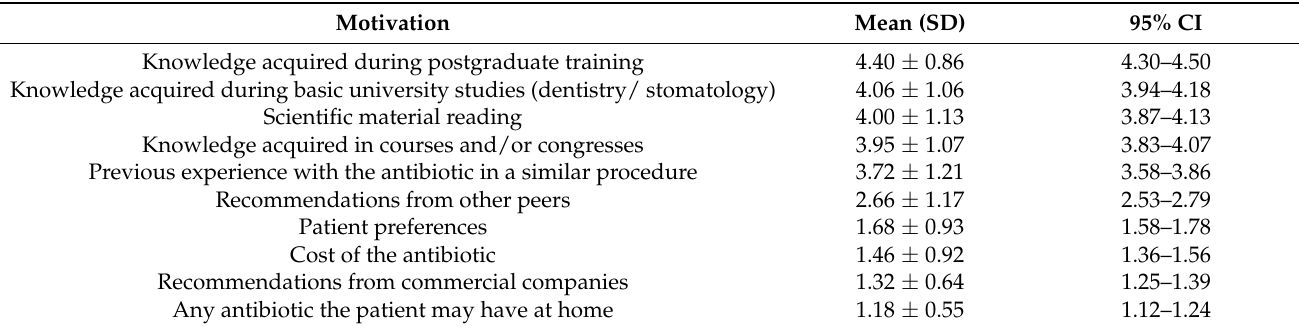
Table 5. Factors determining the prescription of antibiotics in oral implantology treatments ranked by preferences of the professionals